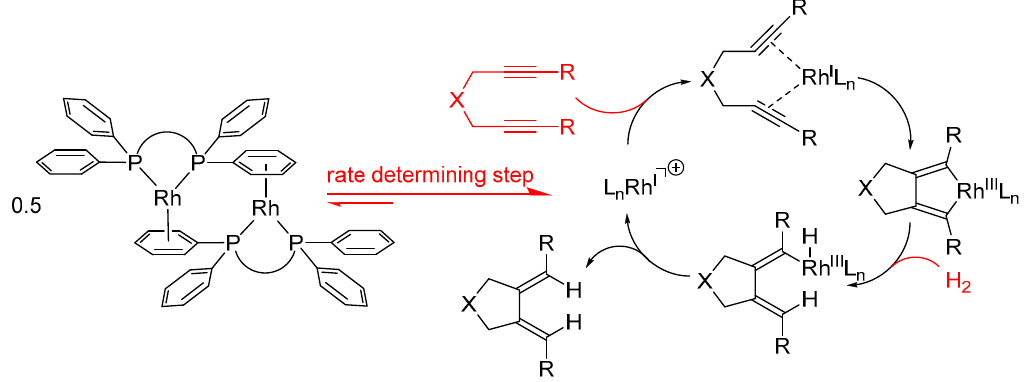
Scheme 14. Mechanism of rhodium / BINAP promoted reductive cyclization of 1,6-diyne in DCM under Scheme 14: Mechanism of rhodium/BINAP promoted reductive cyclization of 1,6-diyne in DCM a hydrogen atmosphere. under a hydrogen atmosphere. [195]